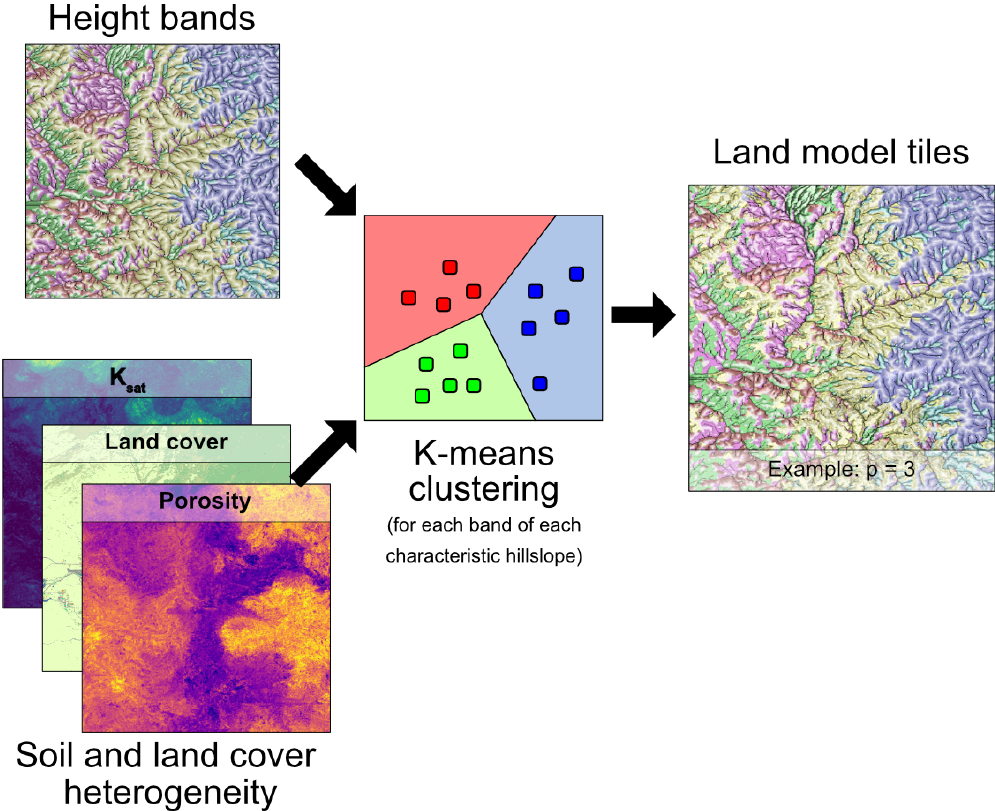
Figure 5. For each height band of each characteristic hillslope, the corresponding fine-scale grid cells are clustered into p intra-band tiles according to their land cover and soil properties.